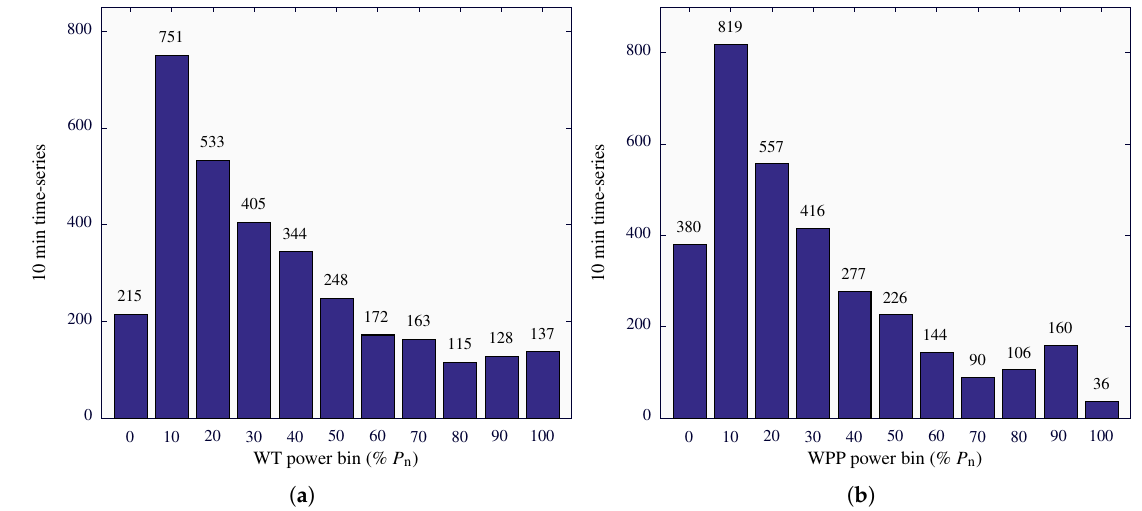
Figure 4. Power distribution of the selected 10 min time series. ( a ) Time series recorded at L1 with respect to the power bin of the WT (2 MW). ( b ) Time series recorded at L2 with respect to the power bin of the WPP (32